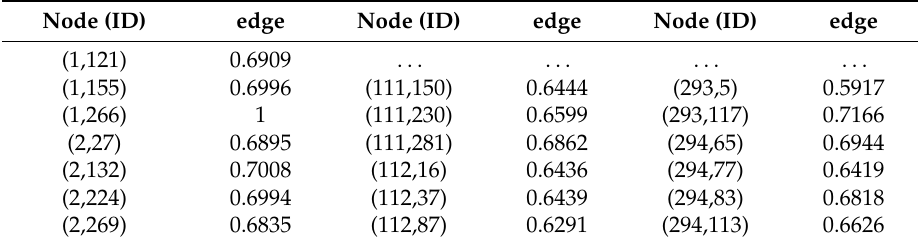
Table 3. The adjacency graph polygon model.